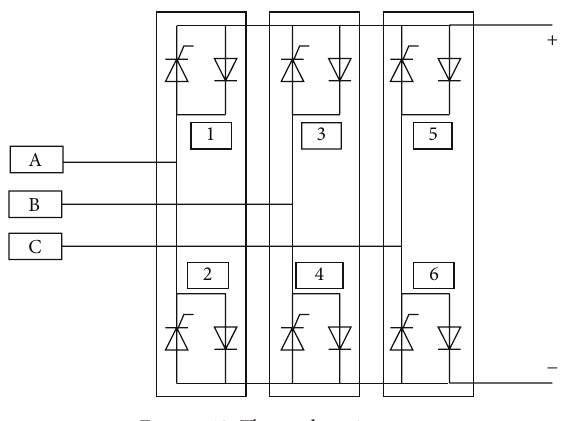
Figure 10: Three-phase inverter.